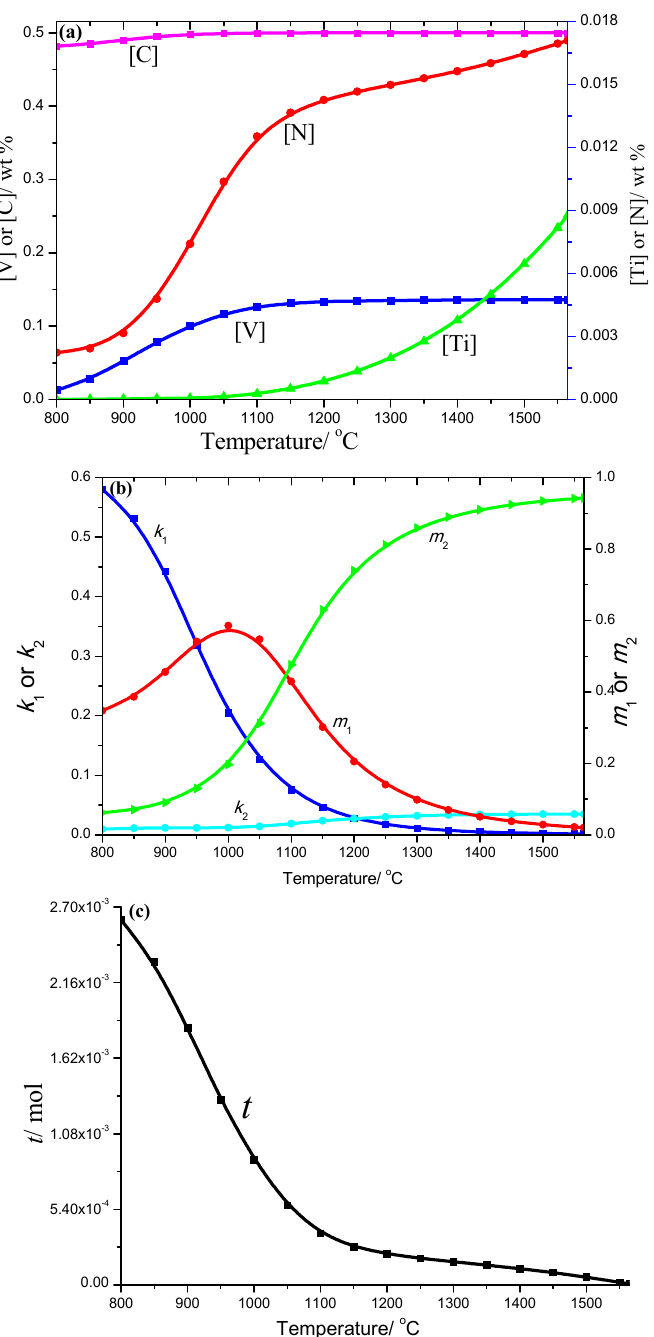
Figure 3. ( a ) Change of solid solution contents; ( b ) k 1 , k 2 , m 1 , m 2 constants and ( c ) total moles